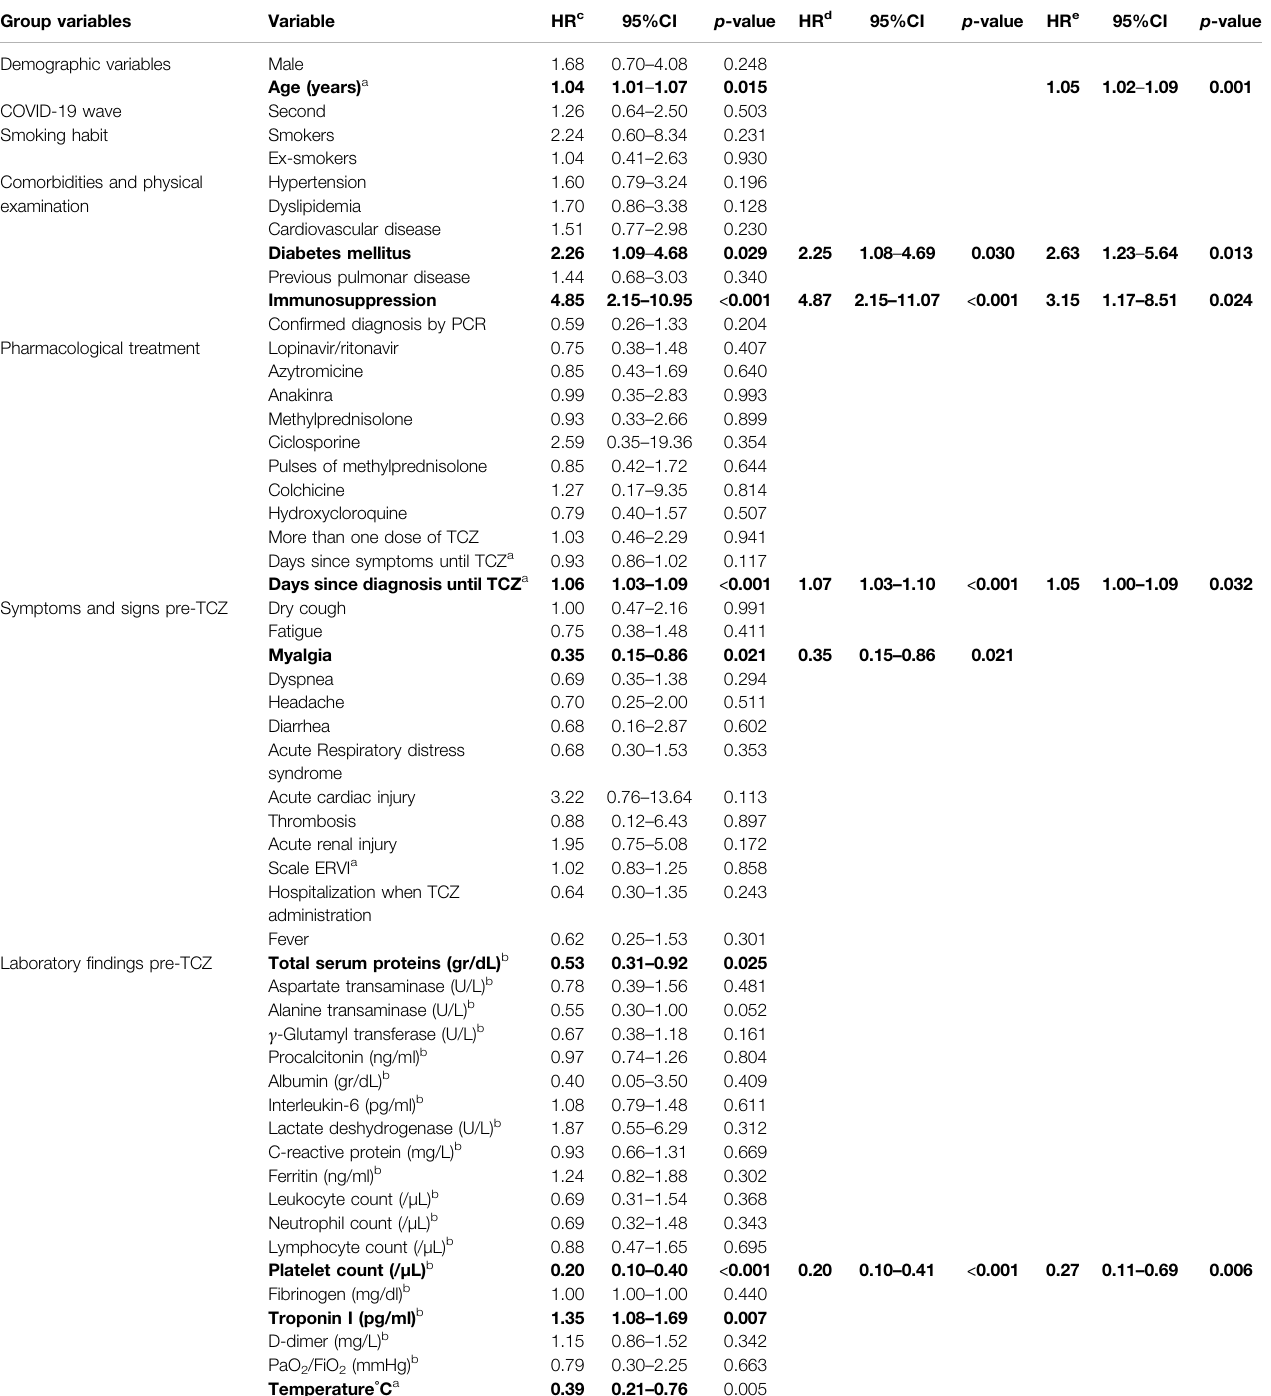
TABLE 2 | Association between baseline variables and time to death. Group variables Demographic